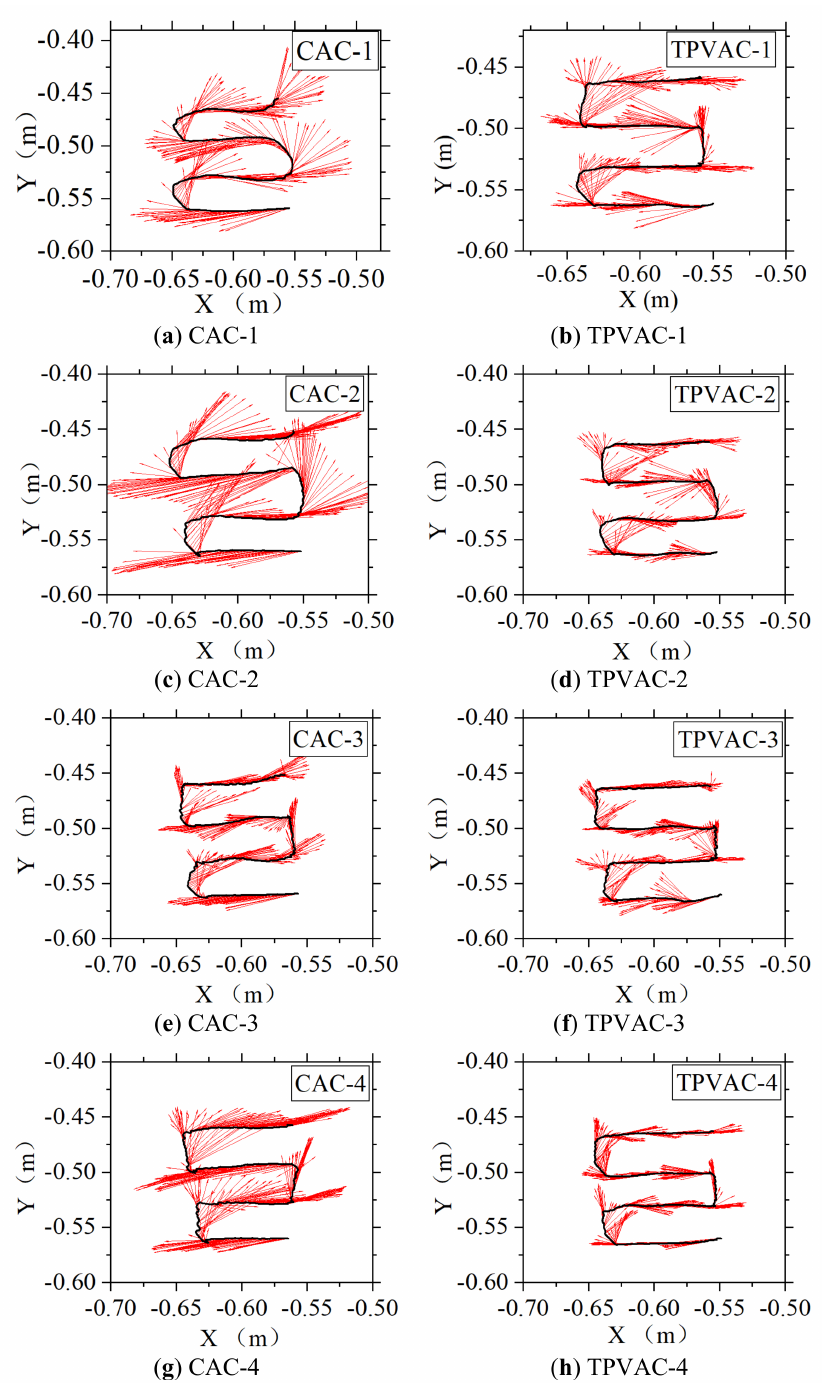
Figure 6. Robot end tool trajectories (black lines) and interaction forces (red arrows) of the four groups of comparative